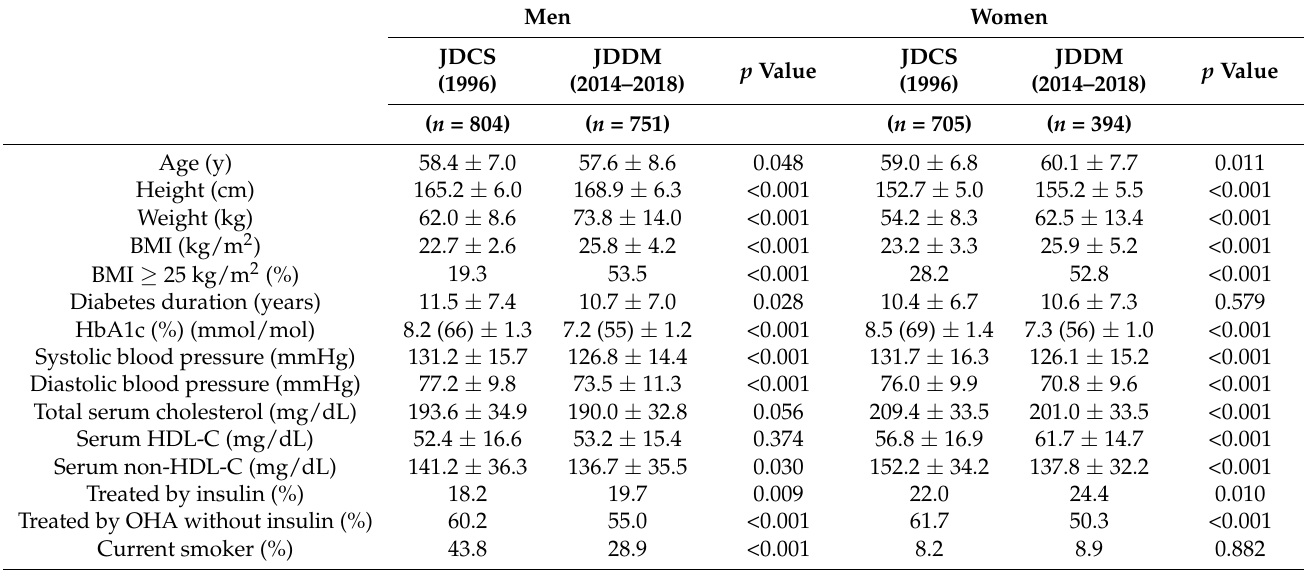
Table 1. Clinical characteristics of participants in two studies of Japanese type 2 diabetes patients 20 years apart, i.e., the Japan Diabetes Complications Study (JDCS, 1996) and the Japan Diabetes Clinical Data Management Study (JDDM,